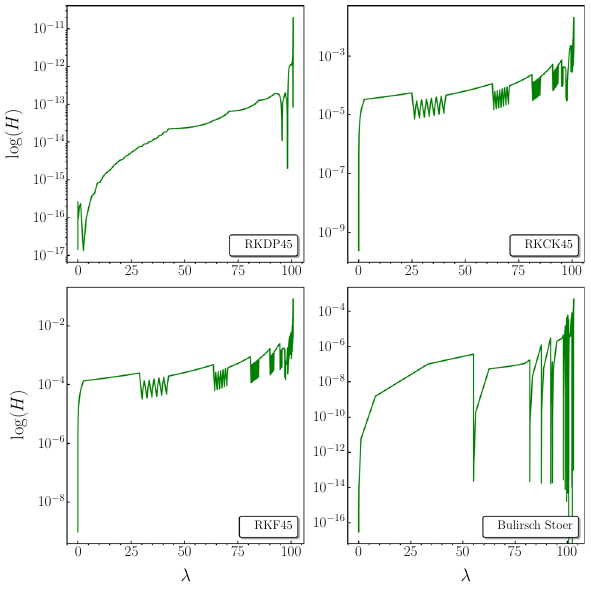
Fig. 5 Hamiltonian constraint in logarithmic scale for a photon that falls. Upper left panel: RK Dormand-Prince; upper right panel: RK Cash-Karp; lower left panel: RK Fehlberg; lower right panel: BS algorithm. The initial conditions are: r 0 = 100, θ 0 ≈ 1 . 570796, φ ≈ 1 . 570796, p ≈ − 0 . 989952, p ≈ − 1 . 009314, p θ ≈ 3 . 750000 t r 0 and p φ ≈ 1 . 250061